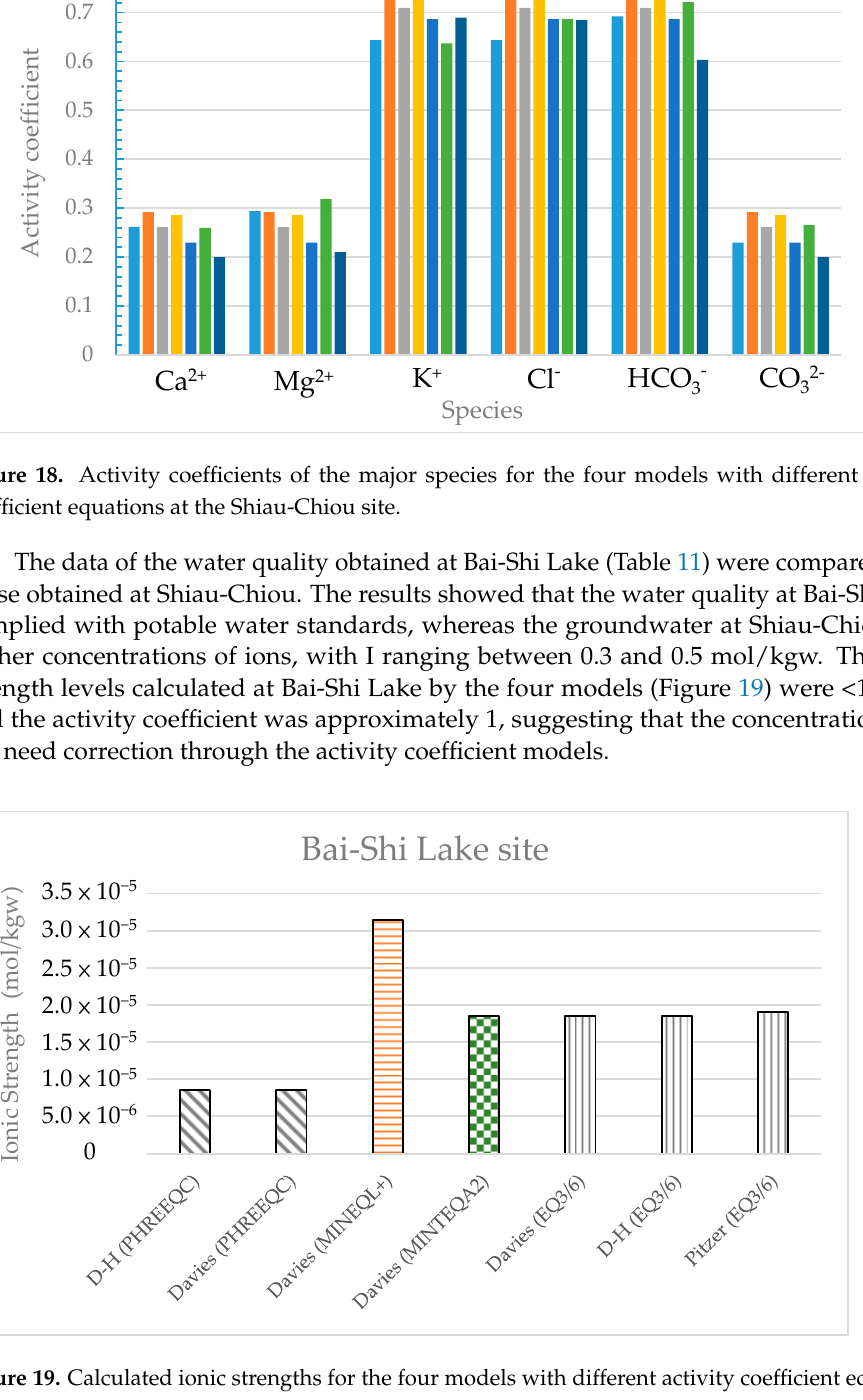
Figure 19. Calculated ionic strengths for the four models with different activity coefficient equations at the Bai-Shi Lake site.